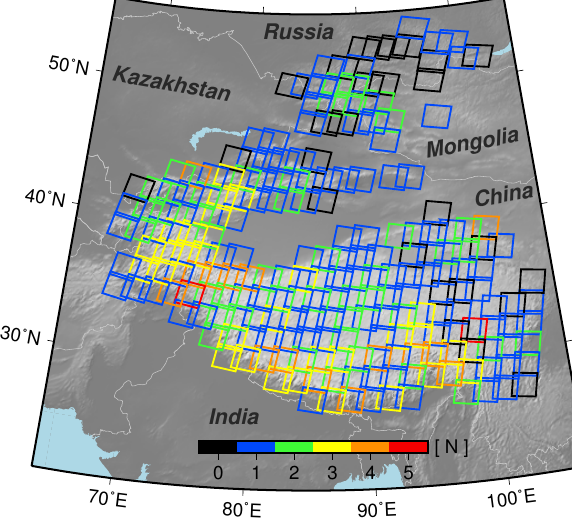
Figure 1. Footprints of Landsat scenes used in this study to delin- eate glaciers over high-mountain Asia. Colours refer to the num- ber [N] of scenes used, while zero values (black squares) indicate that no glaciers exist in that